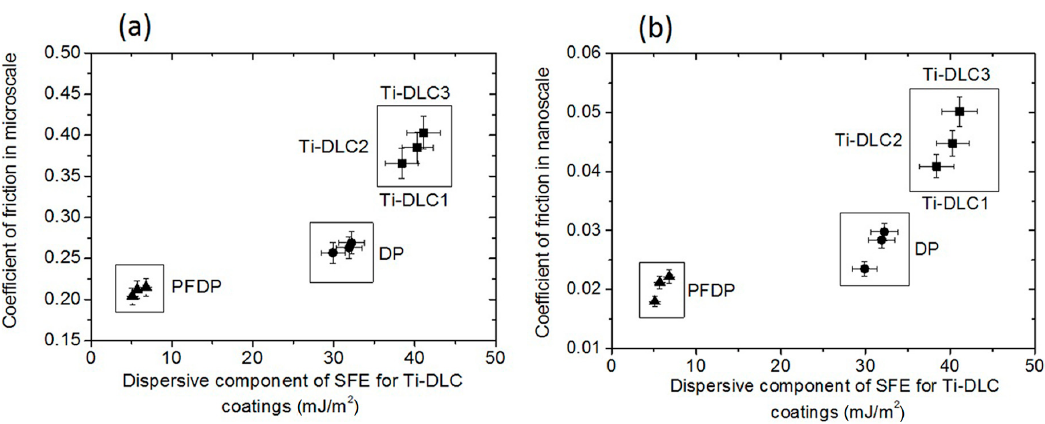
Figure 3. Effect of the dispersive component of surface free energy (SFE) on friction coefficient measured in the ( a ) micro- and ( b ) nanoscale. Figure 3. E ff ect of the dispersive component of surface free energy (SFE) on friction coe ffi cient measured in the ( a ) micro- and ( b ) nanoscale.